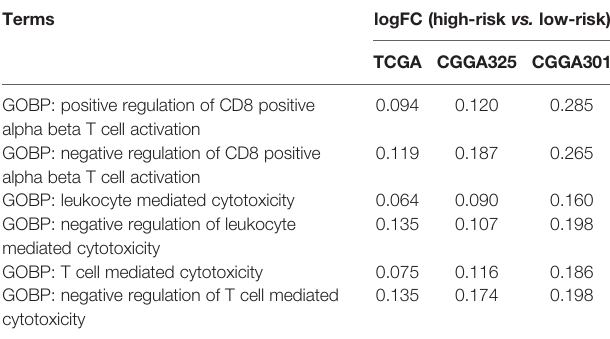
TABLE 1 | The logFC values of mutually antagonistic biological